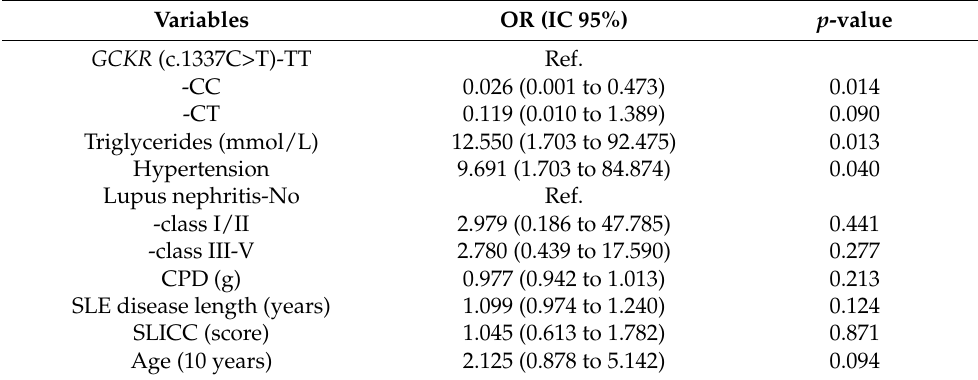
Table 5. Multivariate analysis of the risk factors for carotid plaque in SLE